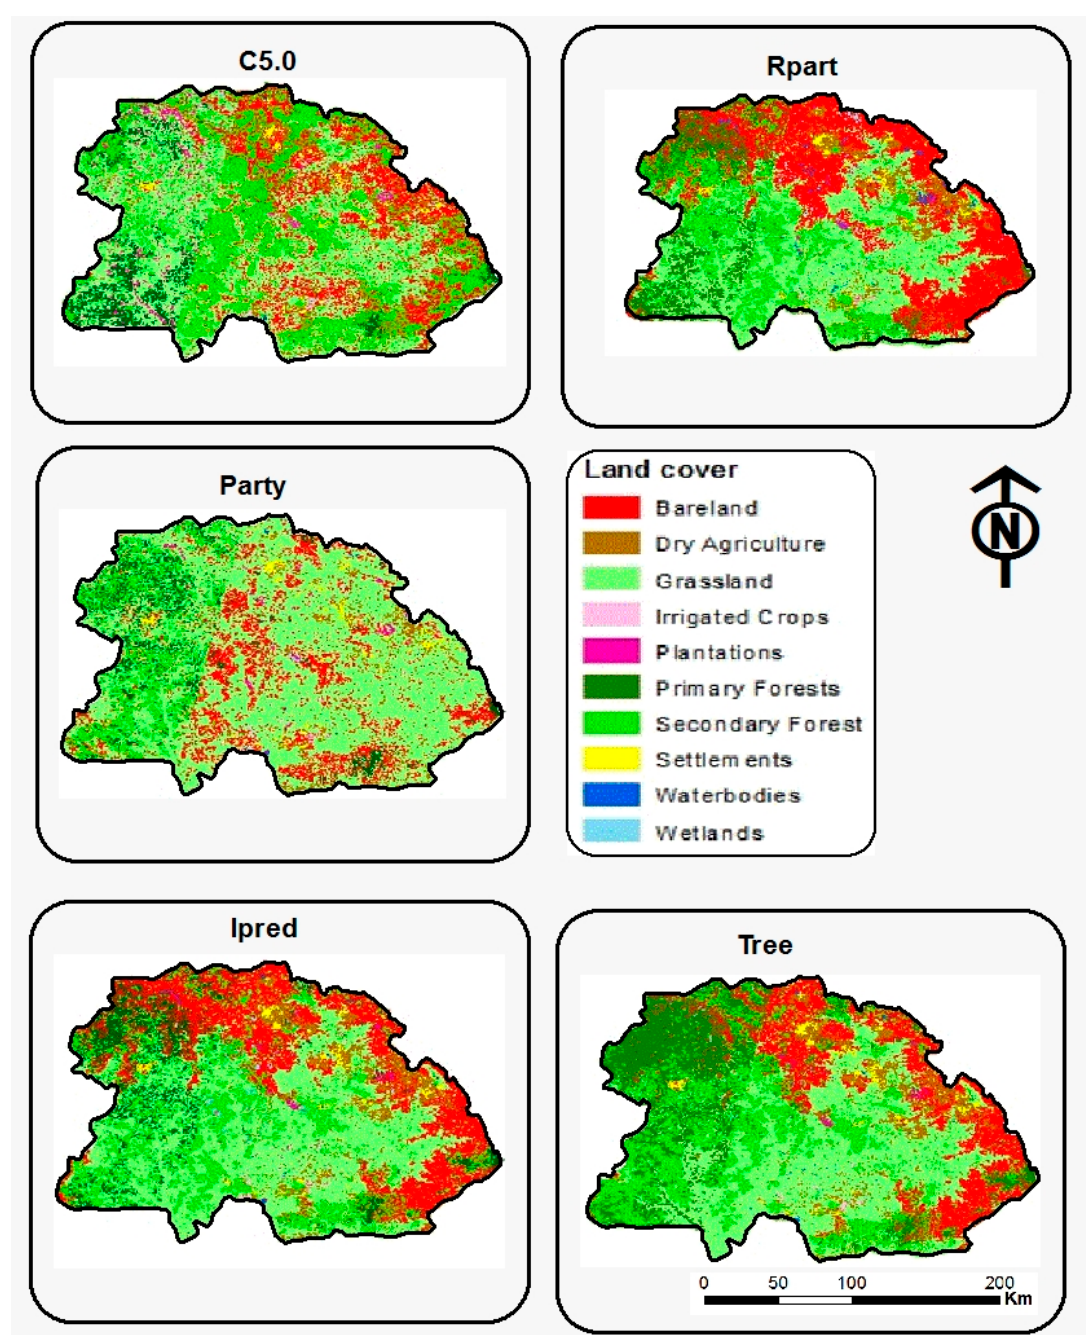
Figure 6. Maps of land cover classification using rulesets developed from the five DT algorithms.